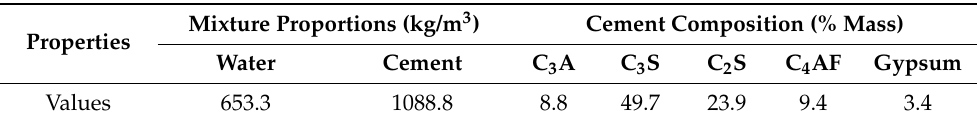
Table 1. Mixture proportions and mineral composition of